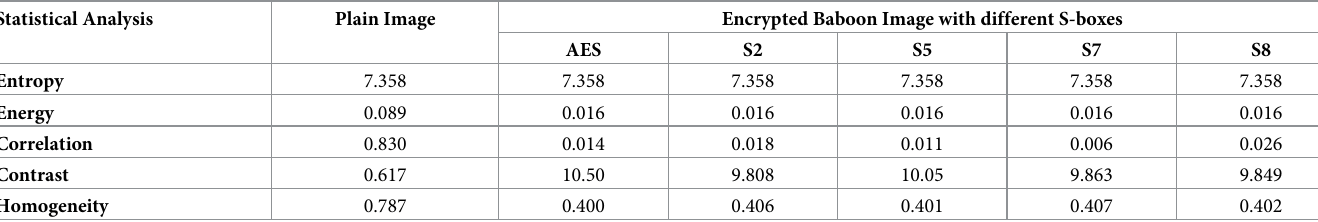
Table 12. Comparison of statistical analysis parameters obtained for plain and encrypted Baboon images. Statistical Analysis